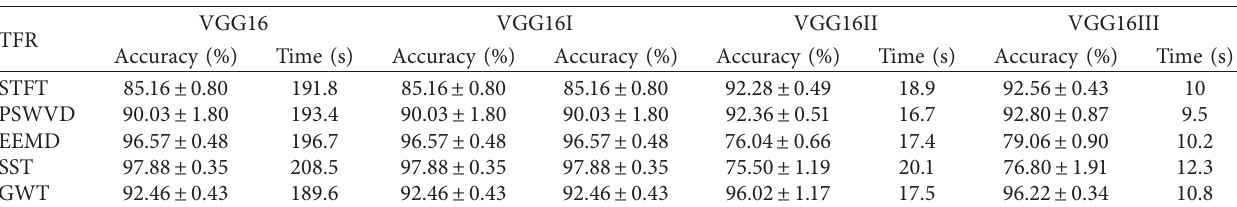
Table 7: Effect of adding BNs and reducing